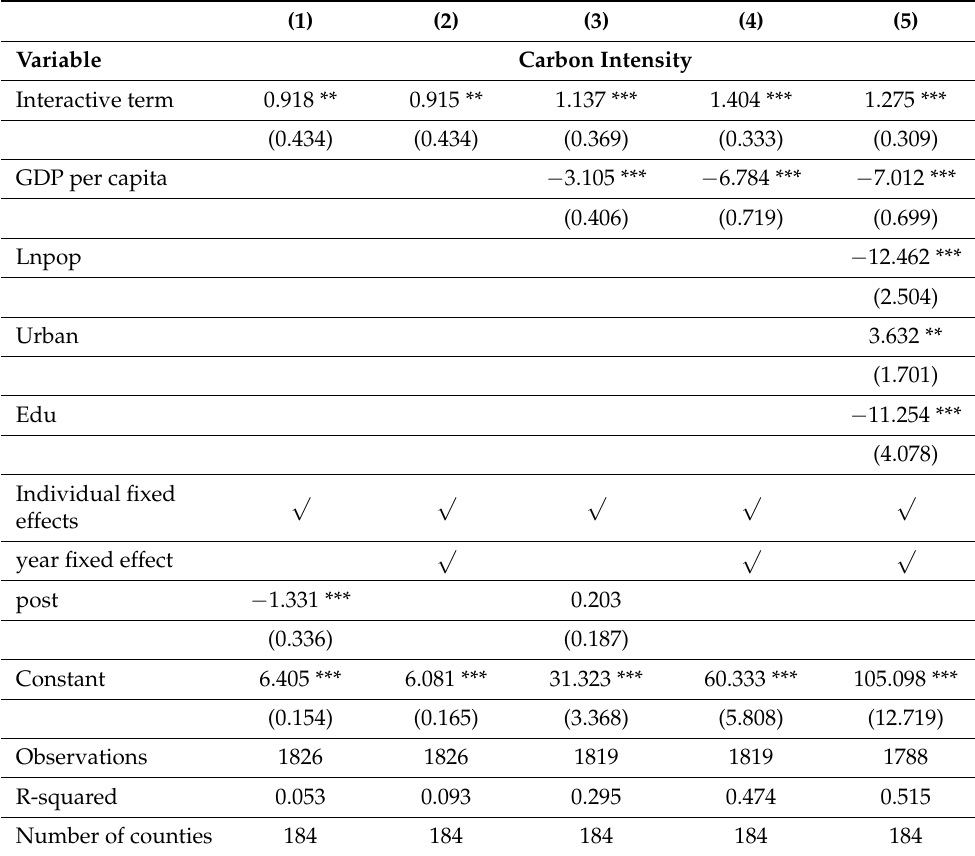
Table 2. Statistical analysis